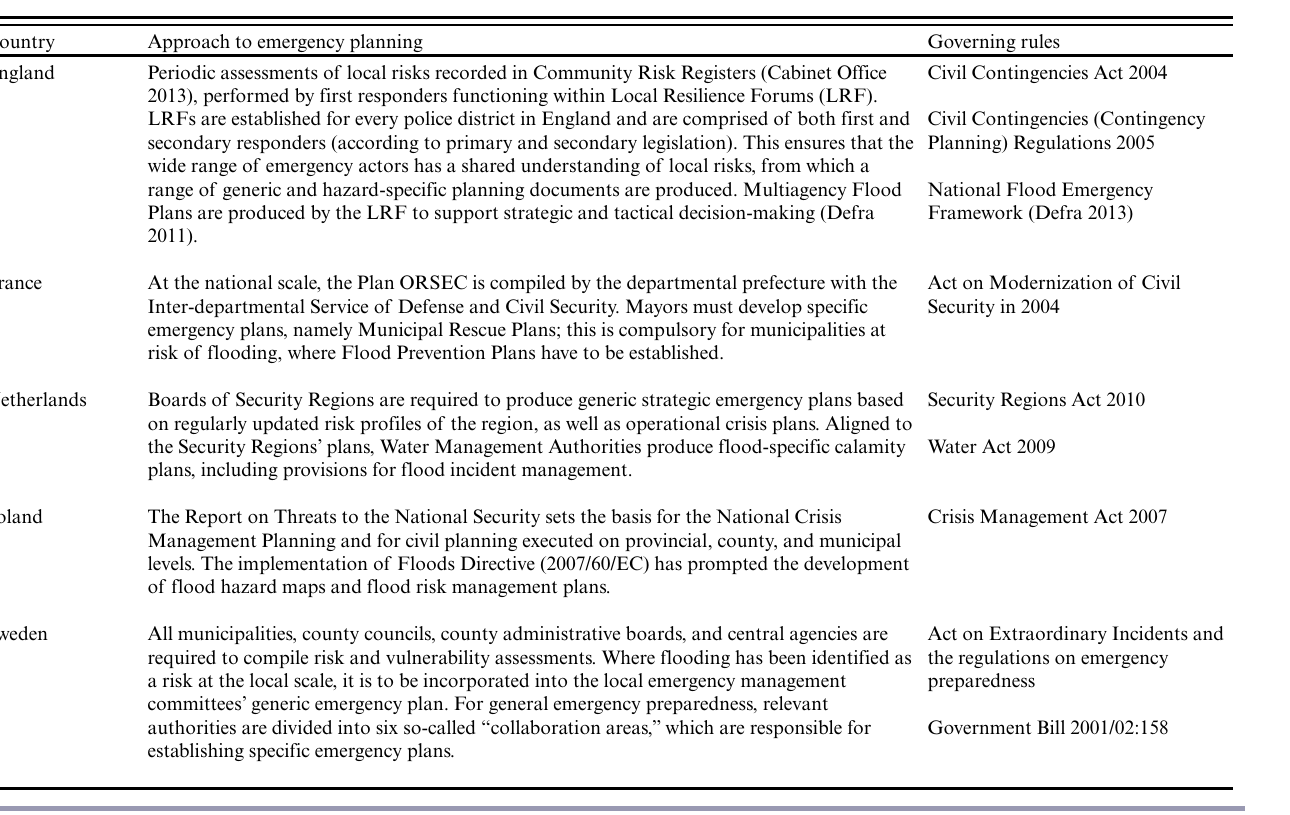
Table 3 . Flood emergency planning arrangements in selected